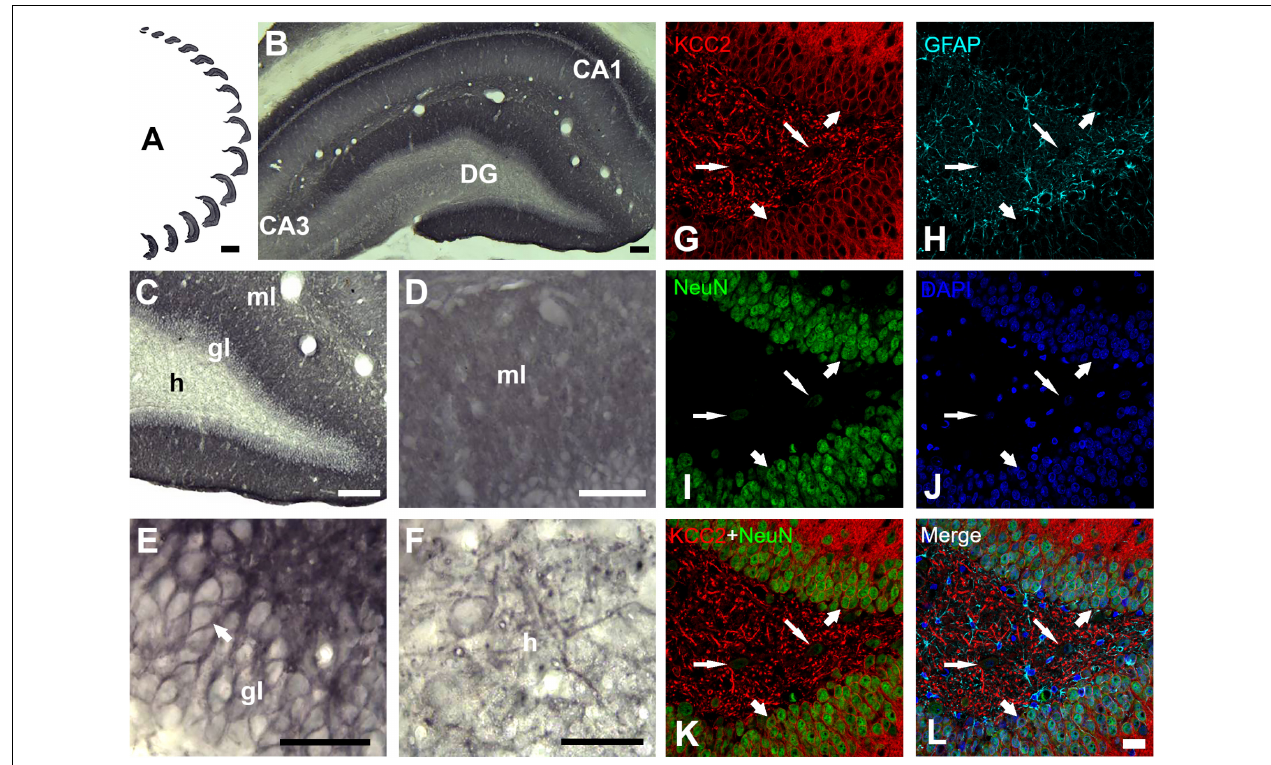
FIGURE 4 | KCC2 expression in dentate gyrus of a rat fed with normal diet. (A) Serial sections of the whole dentate gyrus of the right hemisphere. (B) Panoramic and (C) , higher magnification view of dentate gyrus, ml, molecular layer; gl, granule layer and h, hilus. Higher magnification of molecular layer (D) , granule layer (E) and hilus (F) . KCC2 immunoreactivity in the granule layer was observed in the plasmalemmal region of the granule cell body (perisomal) (E) . In the hilus (F) , KCC2 expression was observed around the polymorphic cells and in neural processes. (G–L) , quadruple fluorescent labeling of KCC2 with NeuN (a neuron-specific marker), GFAP (a marker for astrocytes) and DAPI (a marker for nuclei) of a rat feed with normal diet. KCC2 immunoreactivity (thick arrows) was mainly observed in both cytoplasmic projections and plasmalemmal region of the granule cell body (perisomal), indicating that KCC2 is present in granular neurons (G–L) . KCC2-IR